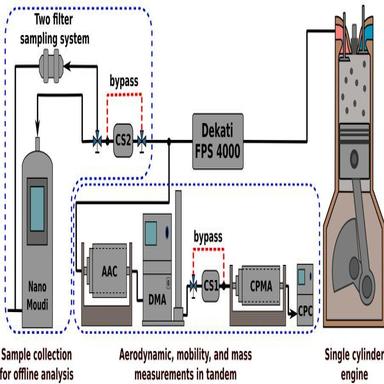
Schematic representation of the experimental setup. Sampling of the exhaust was conducted with a NanoMoudi II cascade impactor to size-select particles and a two-filter collection device to separate the PM (polydisperse particles) and the gas phase. The collection was performed with and without the CS. The online SOF mass fraction measurements were performed with a combination of Aerodynamic Aerosol Classifier (AAC, Cambustion Ltd.), differential mobility analyzer (3080 DMA, TSI Inc.), and cent